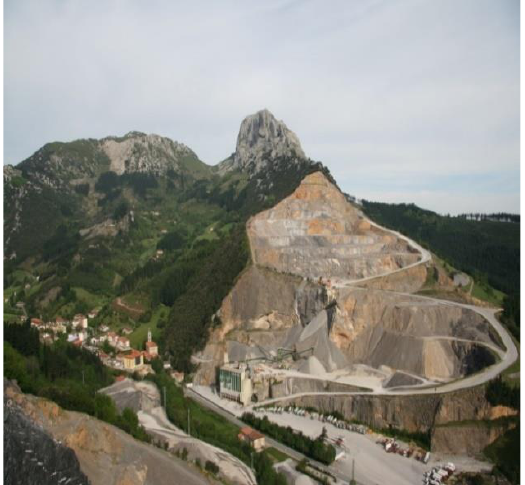
Figure 2. Markomin-Goikoa quarry in Mount Mugarra.